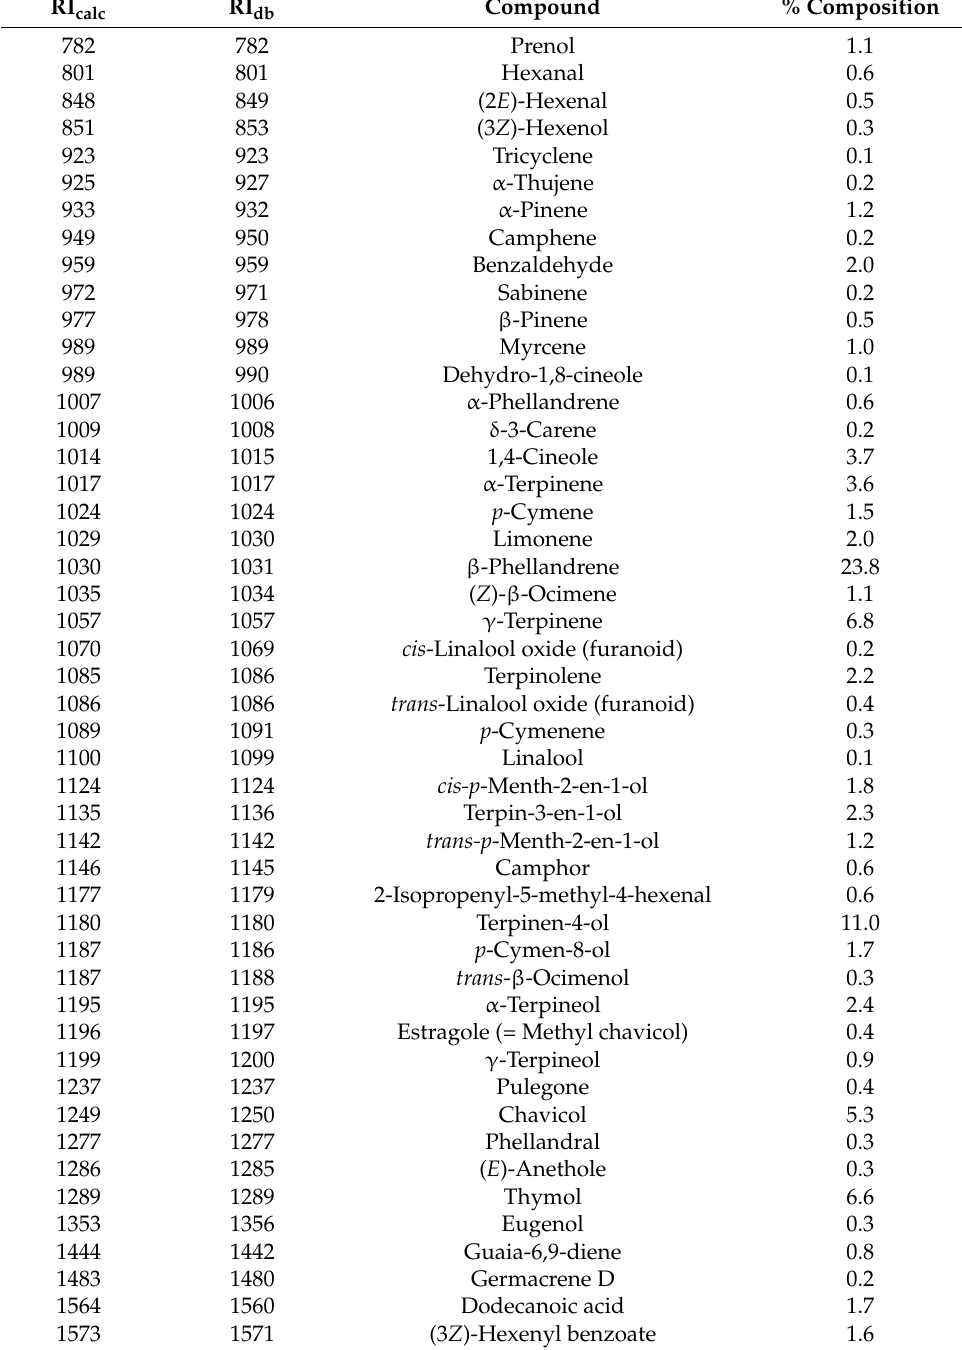
Table 2. Chemical composition of Pinus contorta subsp. contorta leaf essential